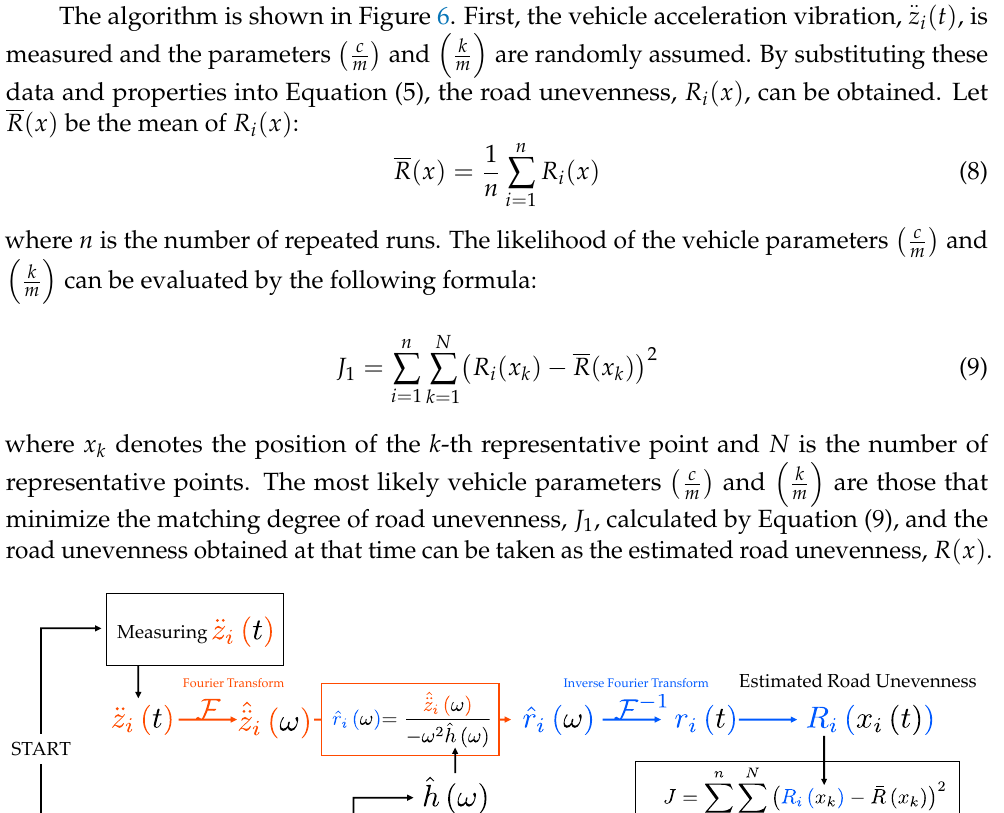
Figure 7. Flowchart of the proposed method of estimating road unevenness components 𝑅 (cid:4593) (cid:4666)𝑥(cid:4667) and 𝑅 (cid:4593)(cid:4593) (cid:4666)𝑥(cid:4667) without prior information about the vehicle parameters (cid:4672) (cid:3030) (cid:3040) (cid:4673) and (cid:4672) (cid:3038) (cid:3040) (cid:4673) . This process does not require the vehicle’s prior information and can also estimate inputs. First, in this process, the vehicle’s vertical acceleration vibrations, 𝑧(cid:4663) (cid:3036) (cid:4666)𝑡(cid:4667) , and acceler- ation of the traveling direction, 𝑎 (cid:3036) (cid:4666)𝑡(cid:4667) , ( = 𝑥(cid:4663) (cid:3036) (cid:4666)𝑡(cid:4667) ) are measured directly by the vibration sen- sor on the vehicle. The vehicle’s position, 𝑥 (cid:3036) (cid:4666)𝑡(cid:4667) , is also measured by the GNSS device. On the other hand, the vehicle parameters (cid:4672) (cid:3030) (cid:3040) (cid:4673) and (cid:4672) (cid:3038) (cid:3040) (cid:4673) are randomly assumed. The speed, 𝑣 (cid:3036) (cid:4666)𝑡(cid:4667) , ( = 𝑥(cid:4662) (cid:3036) (cid:4666)𝑡(cid:4667) ) can be estimated by the measured position, 𝑥 (cid:3036) (cid:4666)𝑡(cid:4667) . Then, 𝑟(cid:4663) (cid:3036) (cid:4666)𝑡(cid:4667) is obtained from Equation (6). The measured time history data can be synchronized spatially. For ex- ample, 𝑟(cid:4663) (cid:3036) (cid:4666)𝑡(cid:4667) can be rewritten in 𝑟(cid:4663) (cid:3036) (cid:4666)𝑥(cid:4667) using 𝑥 (cid:3036) (cid:4666)𝑡(cid:4667) . Similarly, 𝑣 (cid:3036) (cid:4666)𝑡(cid:4667) and 𝑎 (cid:3036) (cid:4666)𝑡(cid:4667) can be- come 𝑣 (cid:3036) (cid:4666)𝑥(cid:4667) and 𝑎 (cid:3036) (cid:4666)𝑥(cid:4667) . Thus, the relationship between the available time history data